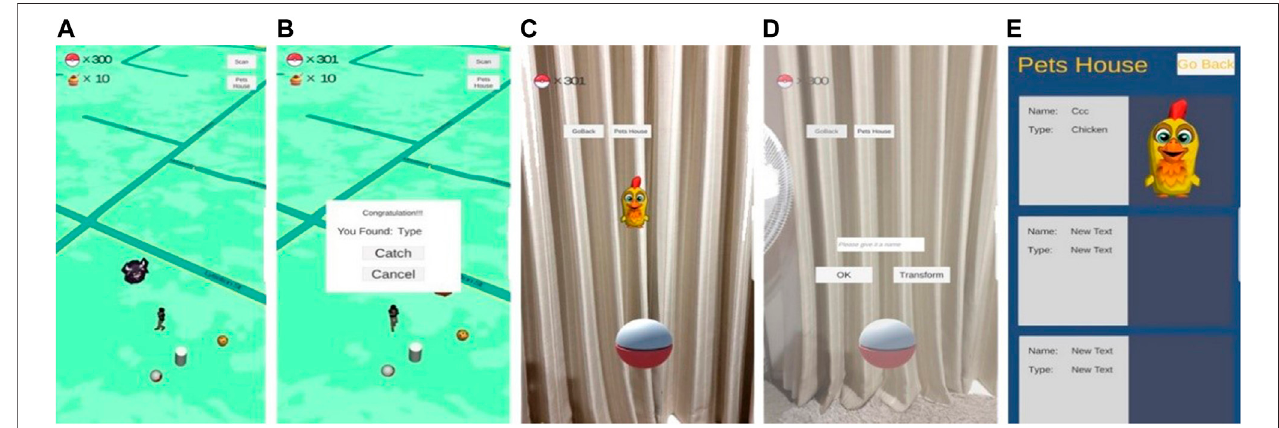
FIGURE 5 | Screenshots of the Pokémon GO clone game: (A) World map showing the player ’ s current geolocation in the real-world and the locations of the creatures, (B) once within the vicinity of the Pokémon, the player is prompted to attempt to catch the creature, (C) the creature appears in the AR view, registered in the real-world 2 m in front of the device camera, (D) the creature is captured, (E) the encyclopedia shows information about the captured creatures.